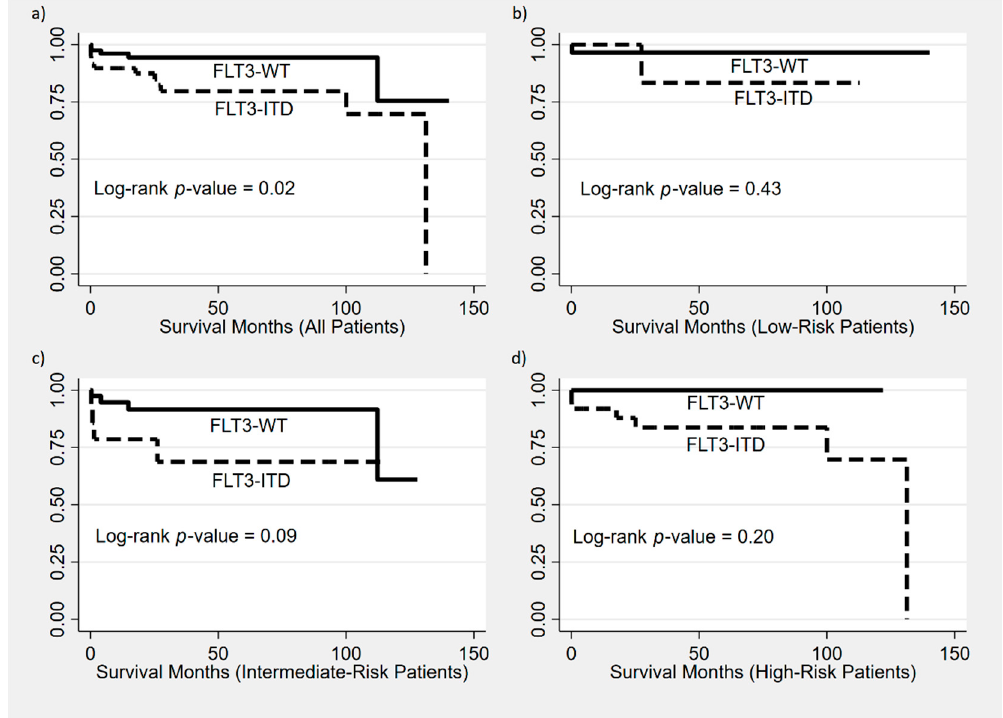
Figure 2. Kaplan–Meier survival curves comparing OS between a) all patients: FLT3 -ITD vs. FLT3 -WT, b) FLT3 -ITD/Sanz LR vs. FLT3 -WT/Sanz LR, c) FLT3 -ITD/Sanz IR vs. FLT3 -WT/Sanz IR, and d) FLT3 -ITD/Sanz HR vs. FLT3 -WT/Sanz HR.